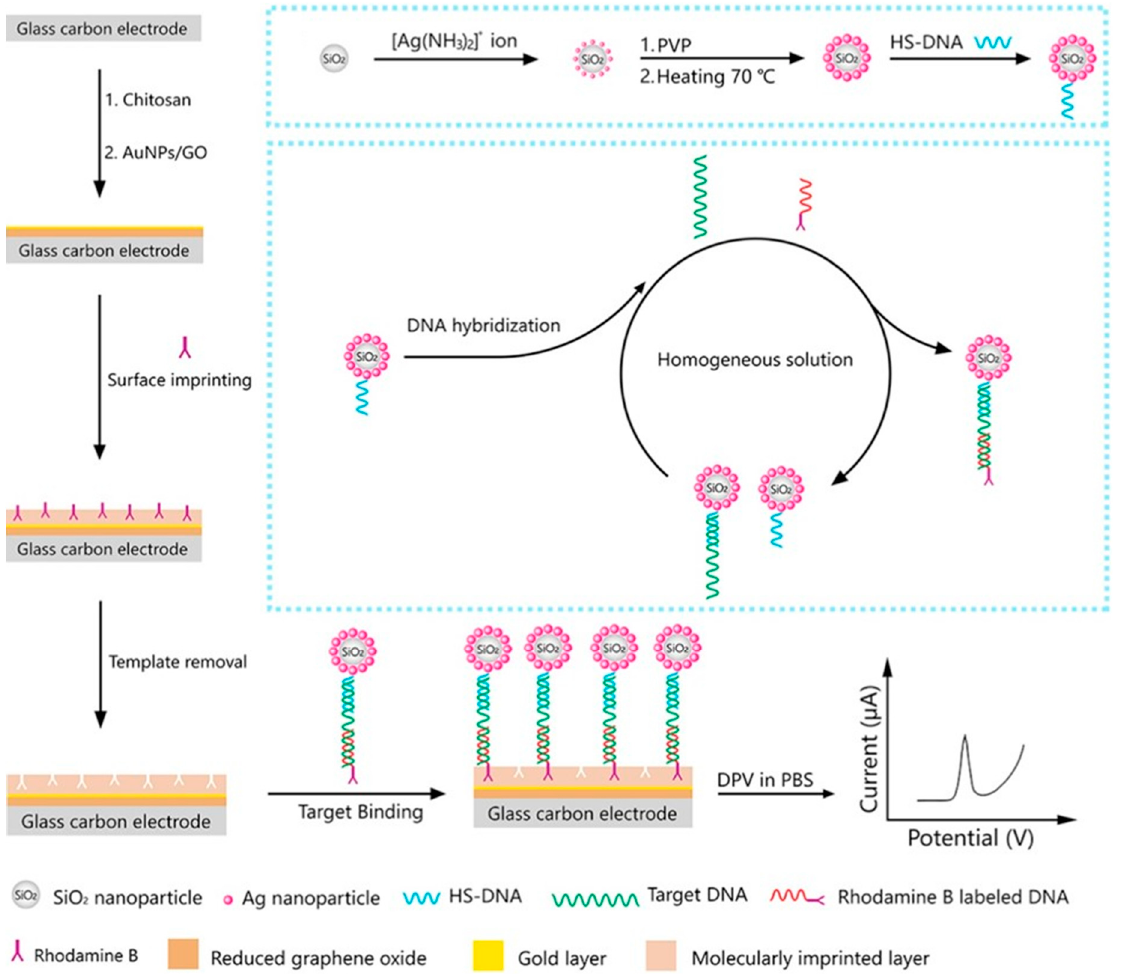
Figure 17. DNA biosensor for the determination of BRCA-1 using DNA-modified SiO 2 @AgNPs as tracing tags. Reprinted and adapted from [193] with permission.